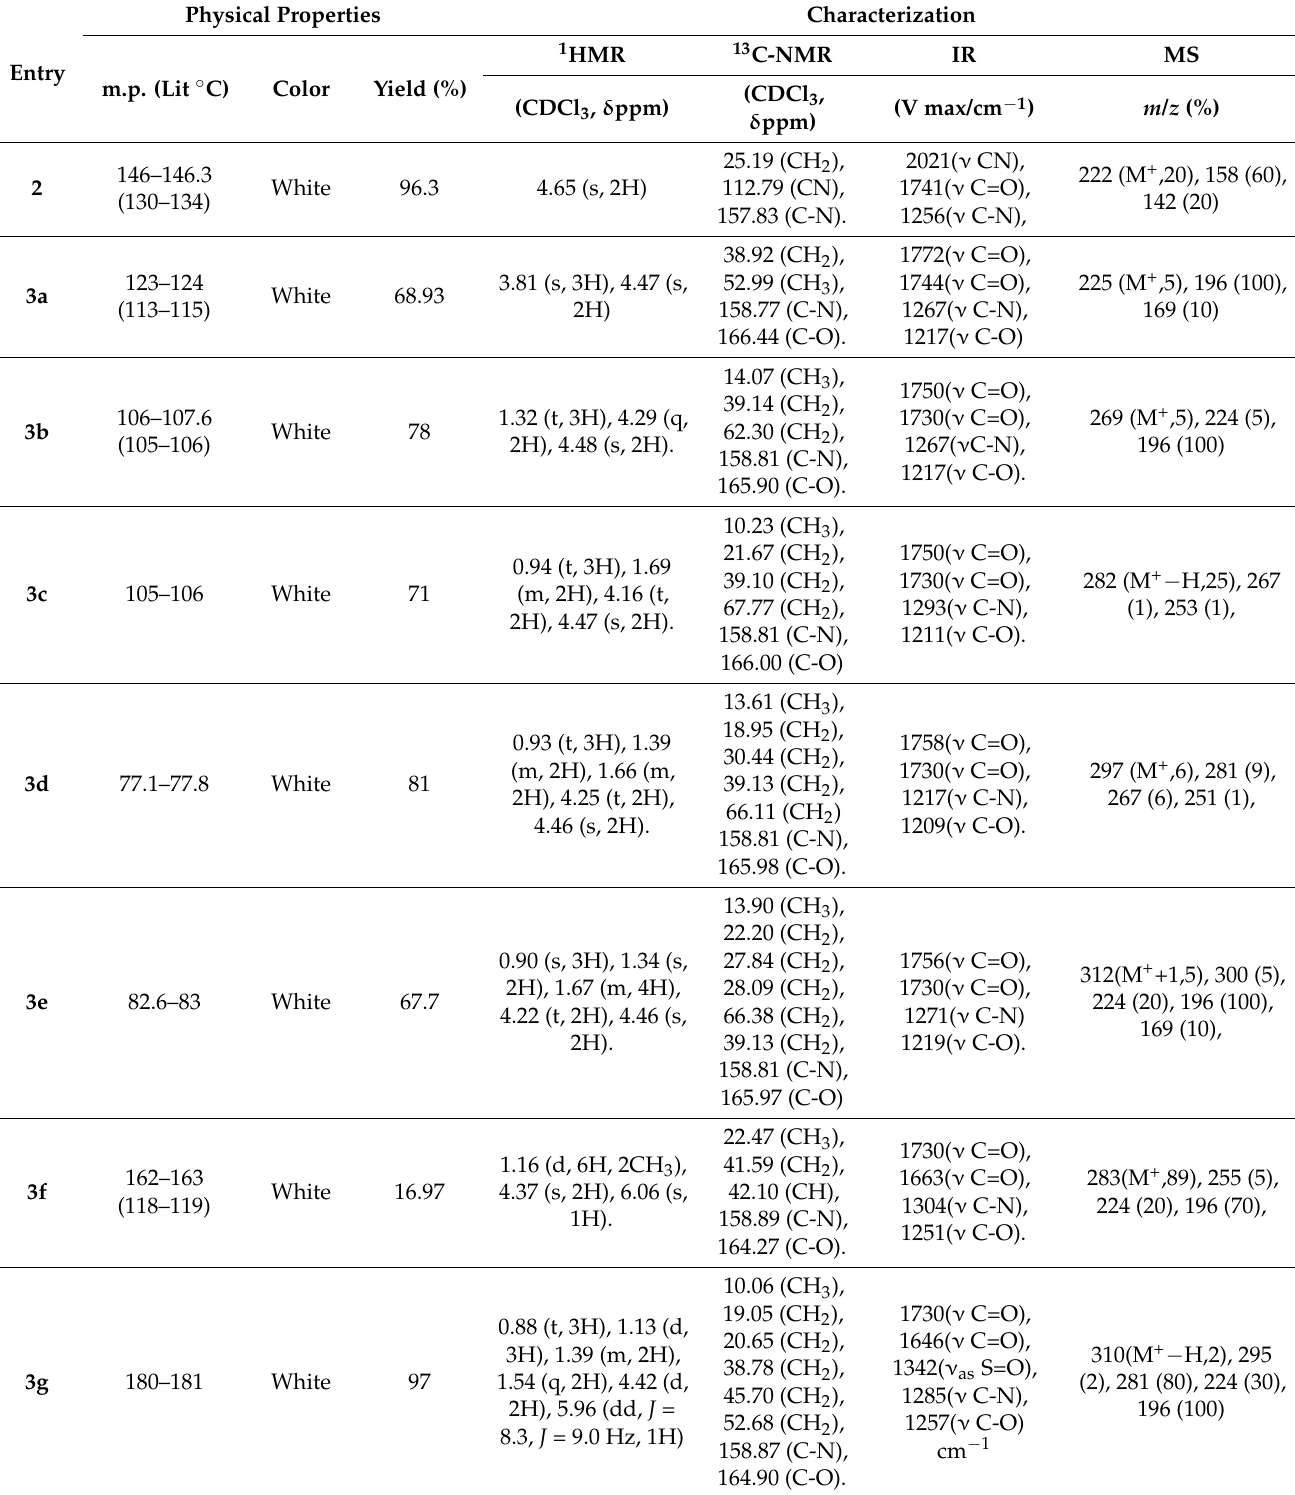
Table 1. Physical properties and spectroscopic characterization of the synthesized compounds 2 , and 3a – g